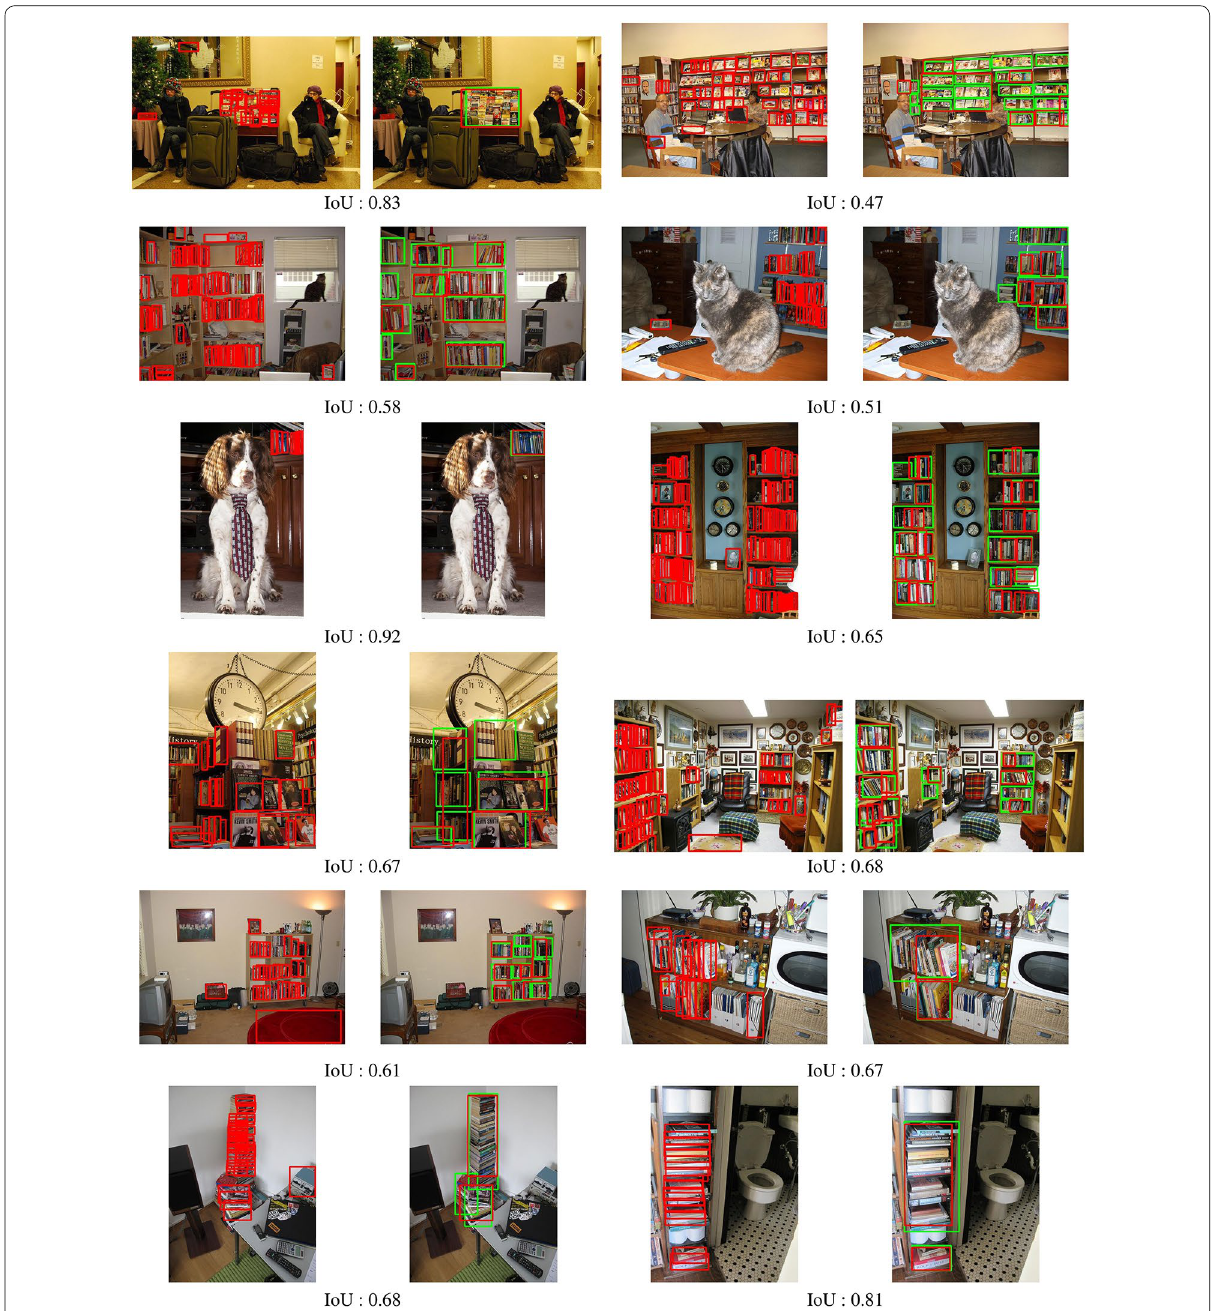
Fig. 20 Extraction examples by the proposed method (2). For each pair, the left side is the result of the SSD and the right side is the result of extraction by the proposed method (red BB: predicted, green BB: